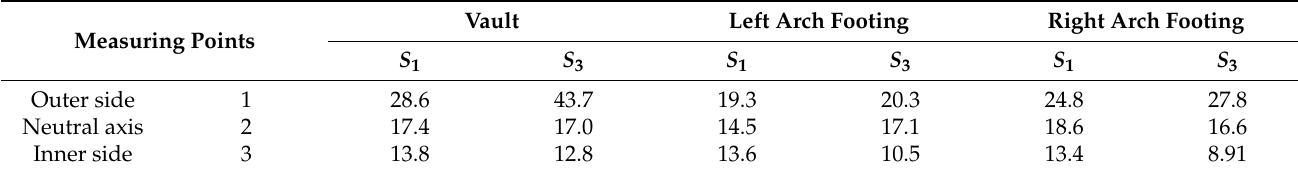
Table 5. The maximum stress of typical section of tunnel lining (unit: MPa).